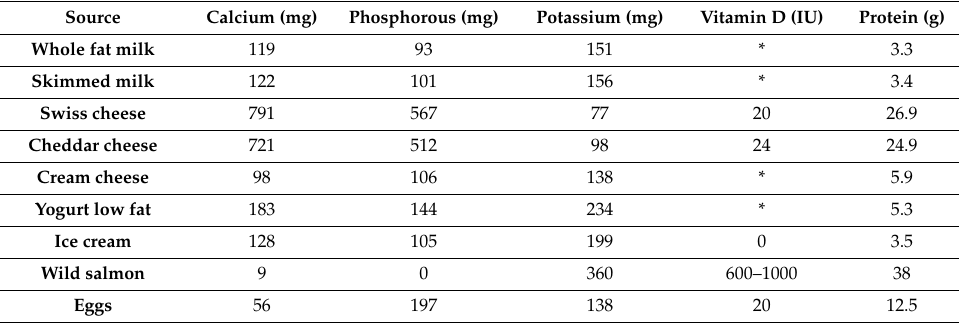
Table 1. Nutrient contents per 100 g of commonly used